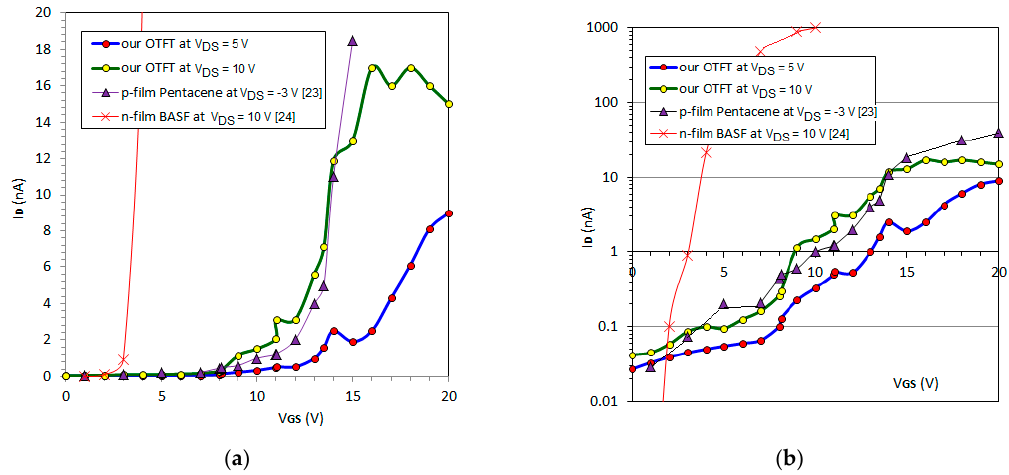
Figure 7. The recorded I D -V GS curves: ( a ) Linear scale on both axes; ( b ) log scale on the vertical axis, as well as the chosen experimental points from the literature [23,24].